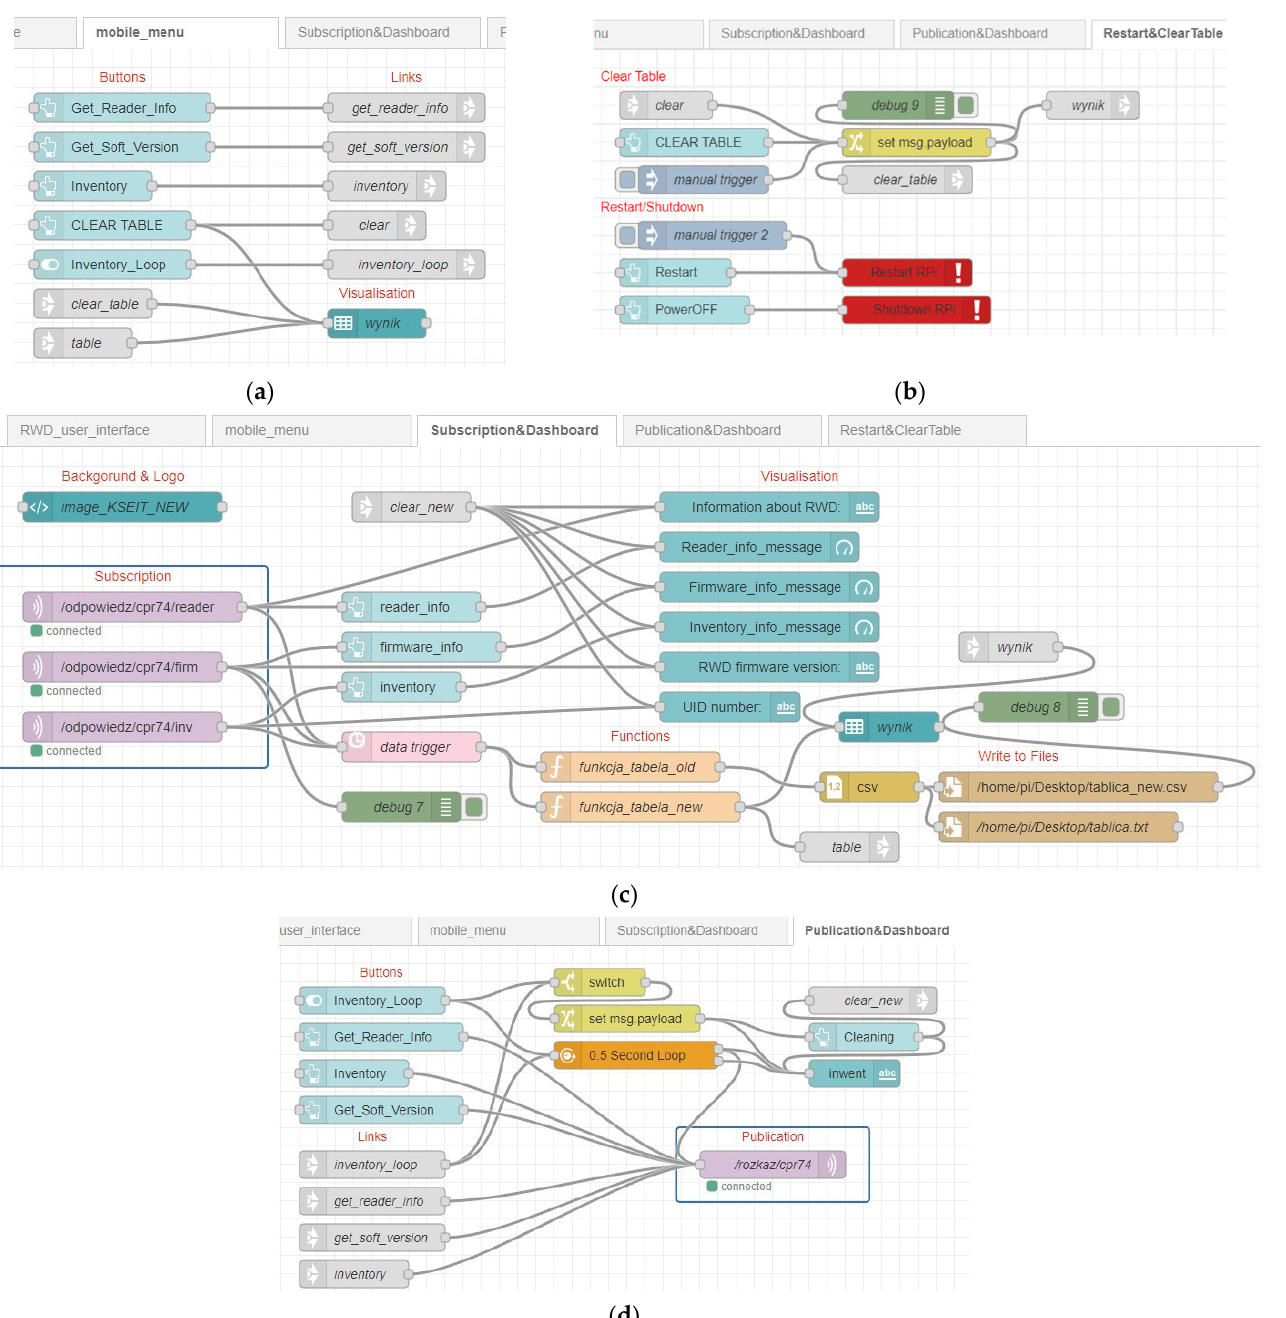
Figure 3. Block diagram of the program flows in Node-Red: ( a ) Mobile menu; ( b ) Reset and clear table; ( c ) Information subscription dashboard; ( d ) Data publication dashboard.